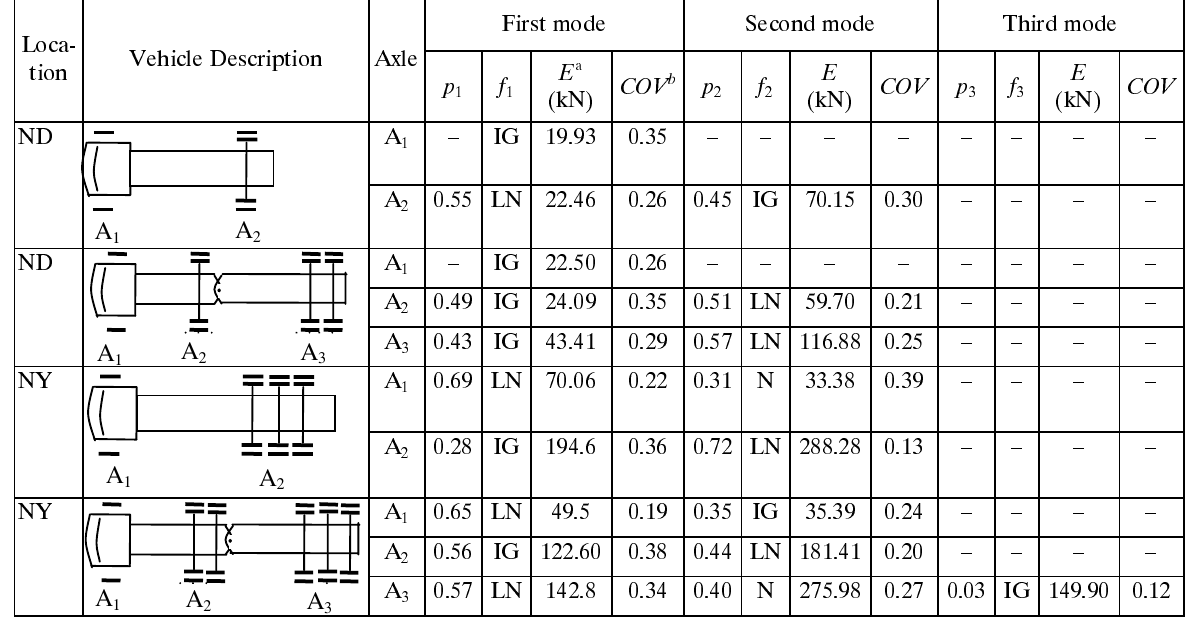
First mode Second